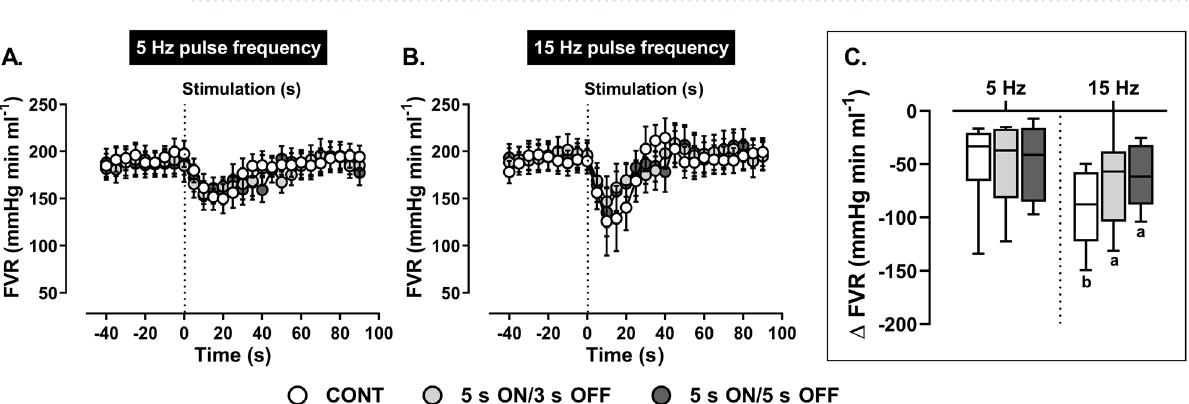
Figure 8. Effect of ( A ) low (5 Hz) and ( B ) high (15 Hz) frequency continuous (CONT) versus intermittent (5 s ON/3 s OFF and 5 s ON/5 s OFF) aortic depressor nerve (ADN) stimulation (0.4 mA, 0.2 ms for 20 s) on reflex reductions in femoral vascular resistance (FVR) in pentobarbital-anesthetized spontaneously hypertensive rats. ( A,B ) show the time trend for the reflex FVR response to ADN stimulation, while ( C ) shows absolute changes (mmHg ml min −1 ) in FVR in response to ADN stimulation. Results are expressed as mean ± SEM ( n = 8), analyzed by a two-way ANOVA followed by followed by Bonferroni’s post hoc test. a: P < 0.05 versus continuous stimulation for each frequency and b: P < 0.05 versus respective stimulation across